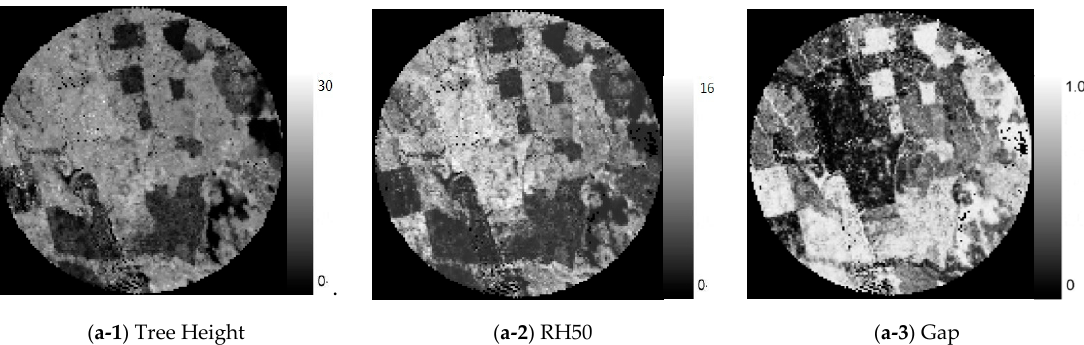
Figure 3. ( a-1 , a-2 , a-3 ) are tree heights, height quantile 50, and the gap map extract from the LVIS waveform, respectively.